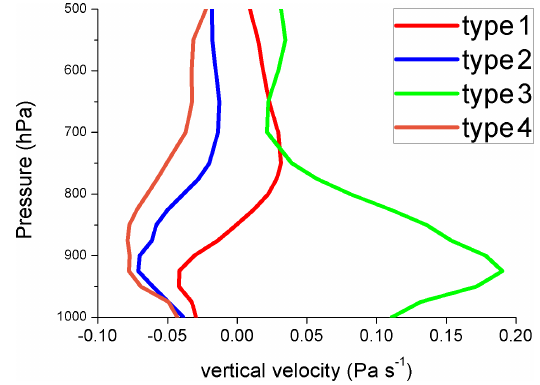
Figure 5. The vertical speed profiles in the four pollution weather types (type 1: red, type 2: blue, type 3: green, and type 4: red) in the Beijing observatory (39.93 ◦ N, 116.28 ◦ E). The negative values rep- resent ascending motion while positive values represent descending motion under the pressure coordinate (unit: Pas − 1 ).